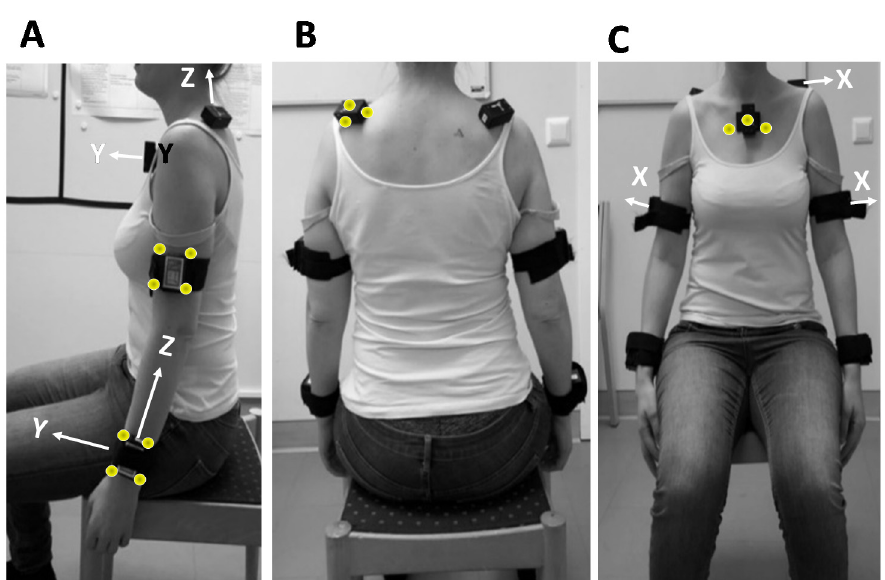
Figure 1. ( A–C ). Illustrates the IMU placements used in Part I (validity) and Part II (reliability). The reflective markers used in Part II were placed either on an orthoplastic shell with the sensor in the center of the shell (upper and lower arms, ( A ) or directly on the sensor’s front and sides (scapula ( B ) and thorax ( C )). The local coordinate systems, marked with white arrows ( B , C ), were all defined so that after calibration/sensor alignment, they were oriented in the same